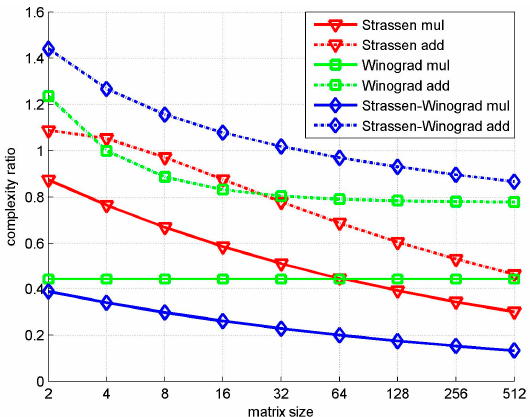
Figure 2. C omparisons of the complexity ratio with different matrix sizes. Figure 2. Comparisons of the complexity ratio with different matrix sizes.